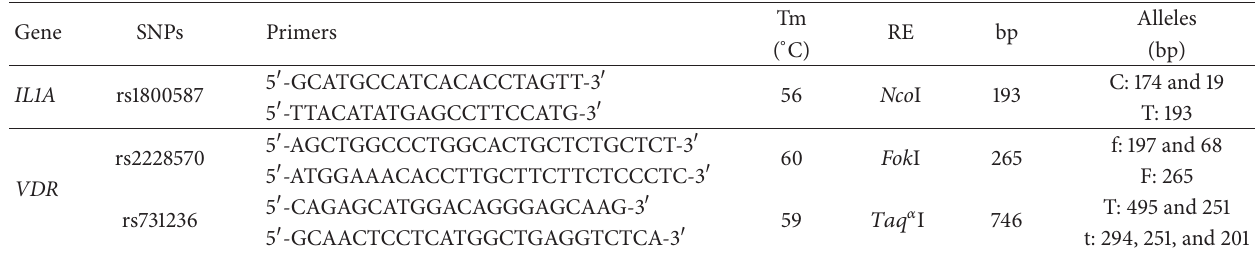
Table 1: Conditions and products of